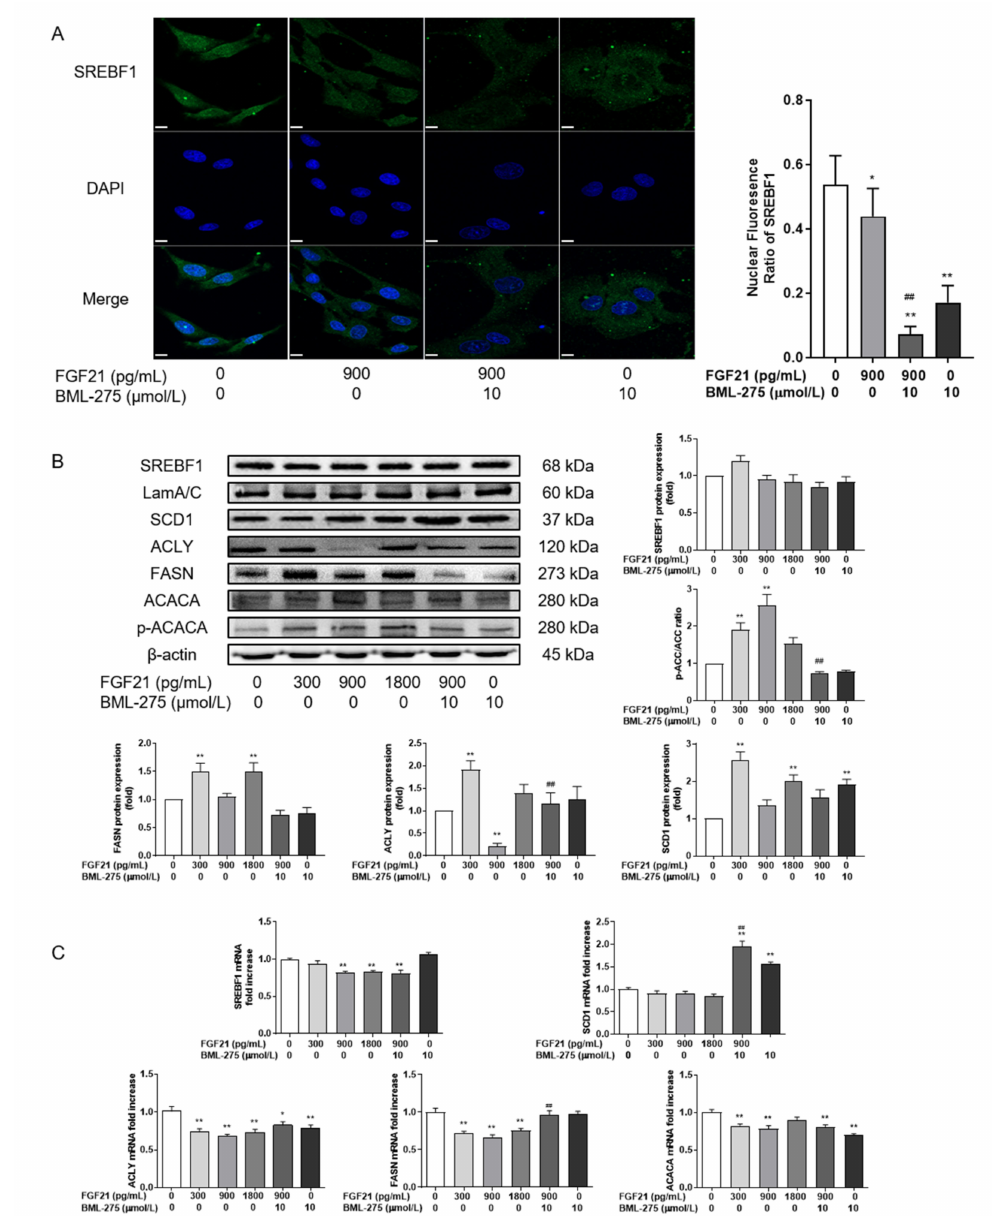
Figure 3. FGF21 inhibits lipid synthesis by reducing SREBF1 nuclear entry and increasing the ACACA phosphorylation ratio. Hepatocytes were treated with FGF21 and BML-275 individually or in combination for 4 h. ( A ) Immunofluorescence staining was conducted to determine the effect of FGF21 or BML-275 on SREBF1 nuclear translocation in hepatocytes ( left ). Green, SREBF1 staining; blue, DAPI nuclear staining (630 × ). Fluorescent intensity from 4 randomly selected microscopic fields per group ( right ). ( B ) Western blot analysis of SREBF1, FASN, SCD1, ACLY, p-ACACA and ACACA. ( C ) Relative mRNA expression levels of SREBF1, FASN, SCD1, ACLY and ACACA. Three independent experiments were performed. Statistical significance was indicated: *, p < 0.05; ** and ## , p < 0.01; * was compared with control group, # was compared with 900 pg/mL